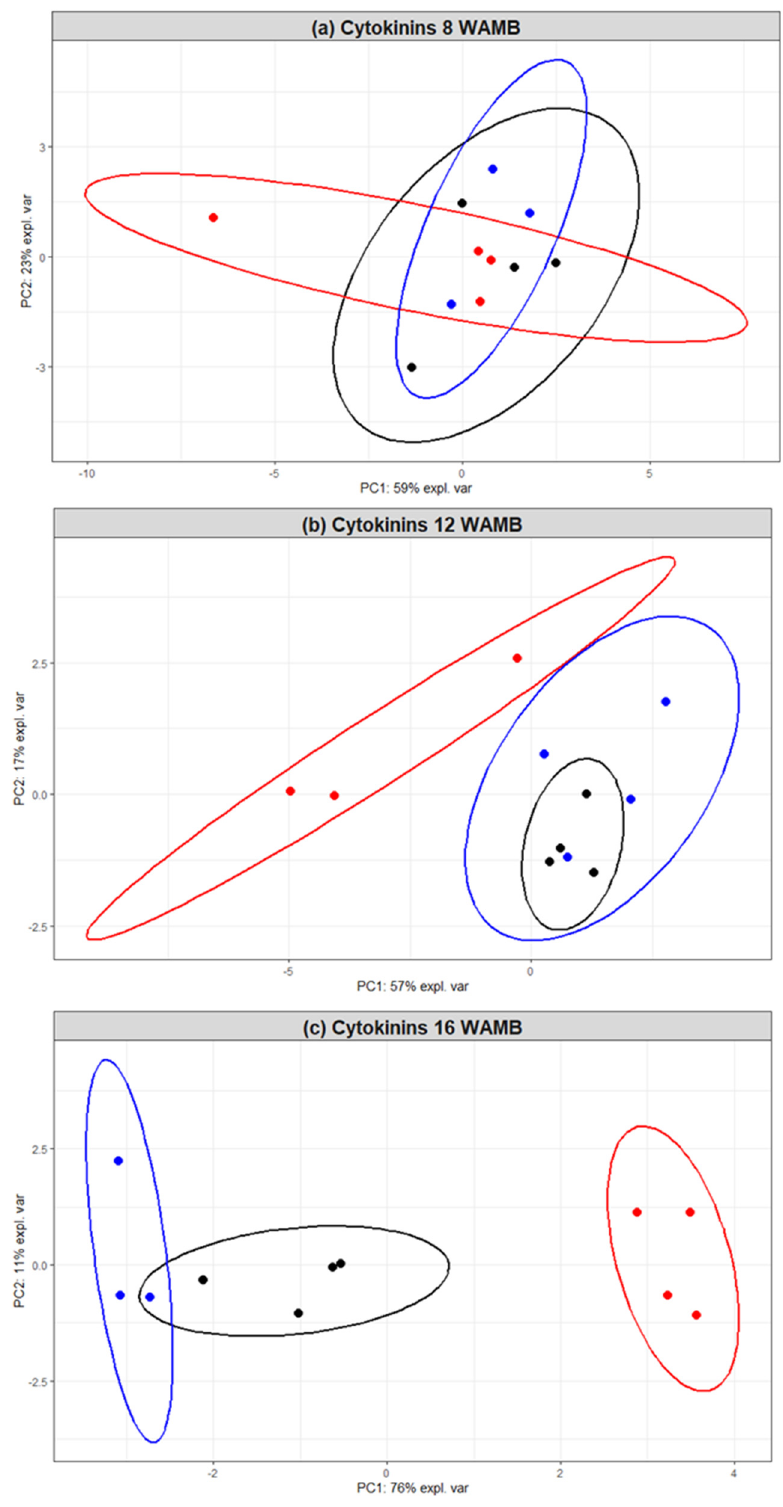
Figure 3. Principal component analysis (PCA) based on cytokinin concentrations in the outer pericarp of developing kiwifruit: ( a ) 8 weeks after mid bloom (WAMB); ( b ) 12 WAMB; ( c ) 16 WAMB. Black, untreated control (vine standard); blue, low carbohydrate supply (carbon starvation); red, high carbohydrate supply. PC, principal component. Confidence ellipses: p < 0.05.